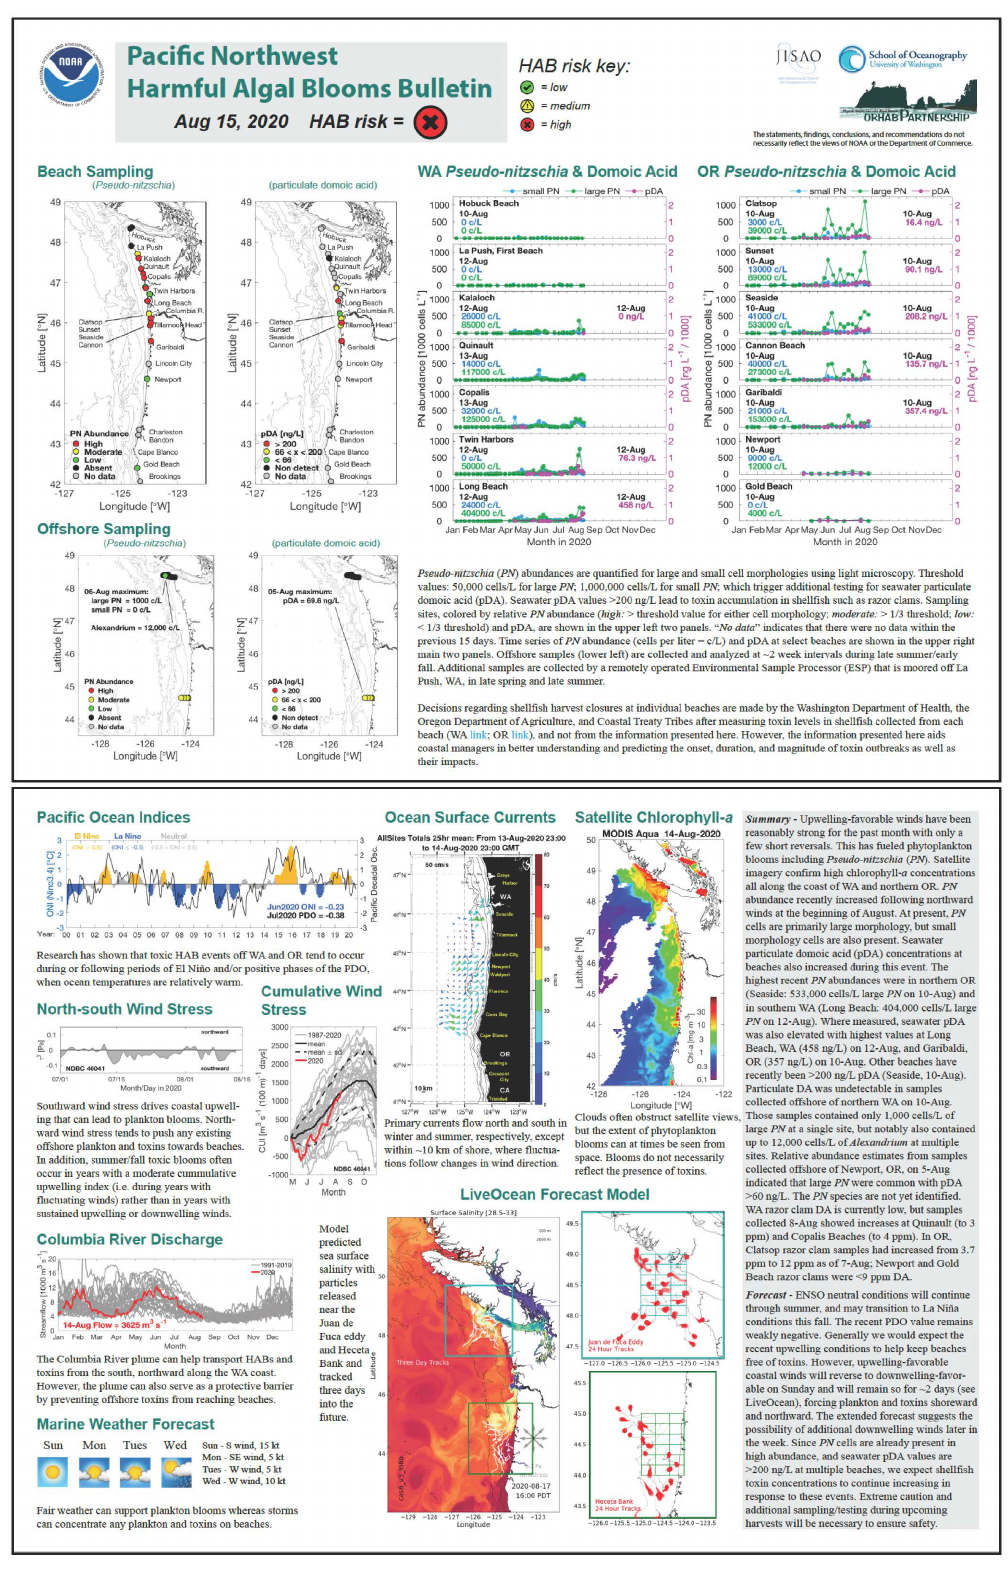
Figure 2. The Pacific Northwest HAB Bulletin, dated 15 August 2020, showing a high HAB risk (red X). The 2 panels of the complete Bulletin are shown here to illustrate its complexity. To view details of this Bulletin, please refer to the web version (http://www.nanoos.org/products/habs/forecasts/bulletins/pnw_hab_bulletin-20200815.pdf; accessed on 4 March 2021). This is the synthesis of several decades of research on HABs in the northeast Pacific Ocean that is responsive to the needs